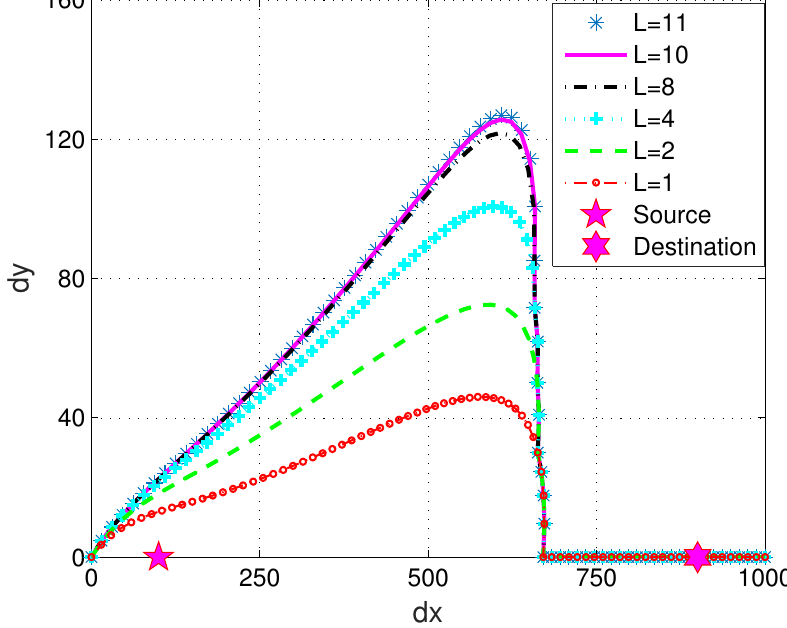
Figure 4. The iterative updates of the UAV trajectory with maximum UAV speed v = 16 m/s and total flight time T = 80 s. The eavesdropper location is uniformly distributed between [ 300,500 ] on the d x axis. The UAV’s trajectory converges in about 10 iterations.